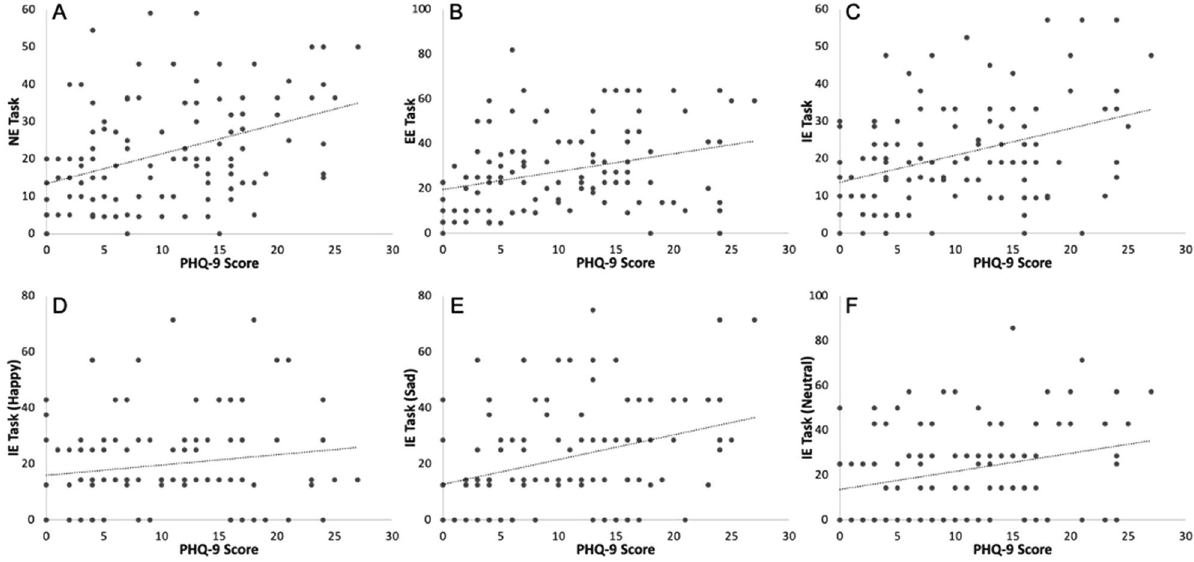
Figure 2. % Commission errors as a function of level of depression. ( A – C ). Pearson Correlations between PHQ-9 scores and % commission errors for the NE ( A ), EE ( B ) and IE ( C ) tasks. ( D , E ). Pearson correlations between PHQ-9 and %commission errors for the IE task, split by emotion: happy( D ), sad ( E ) and neutral ( F